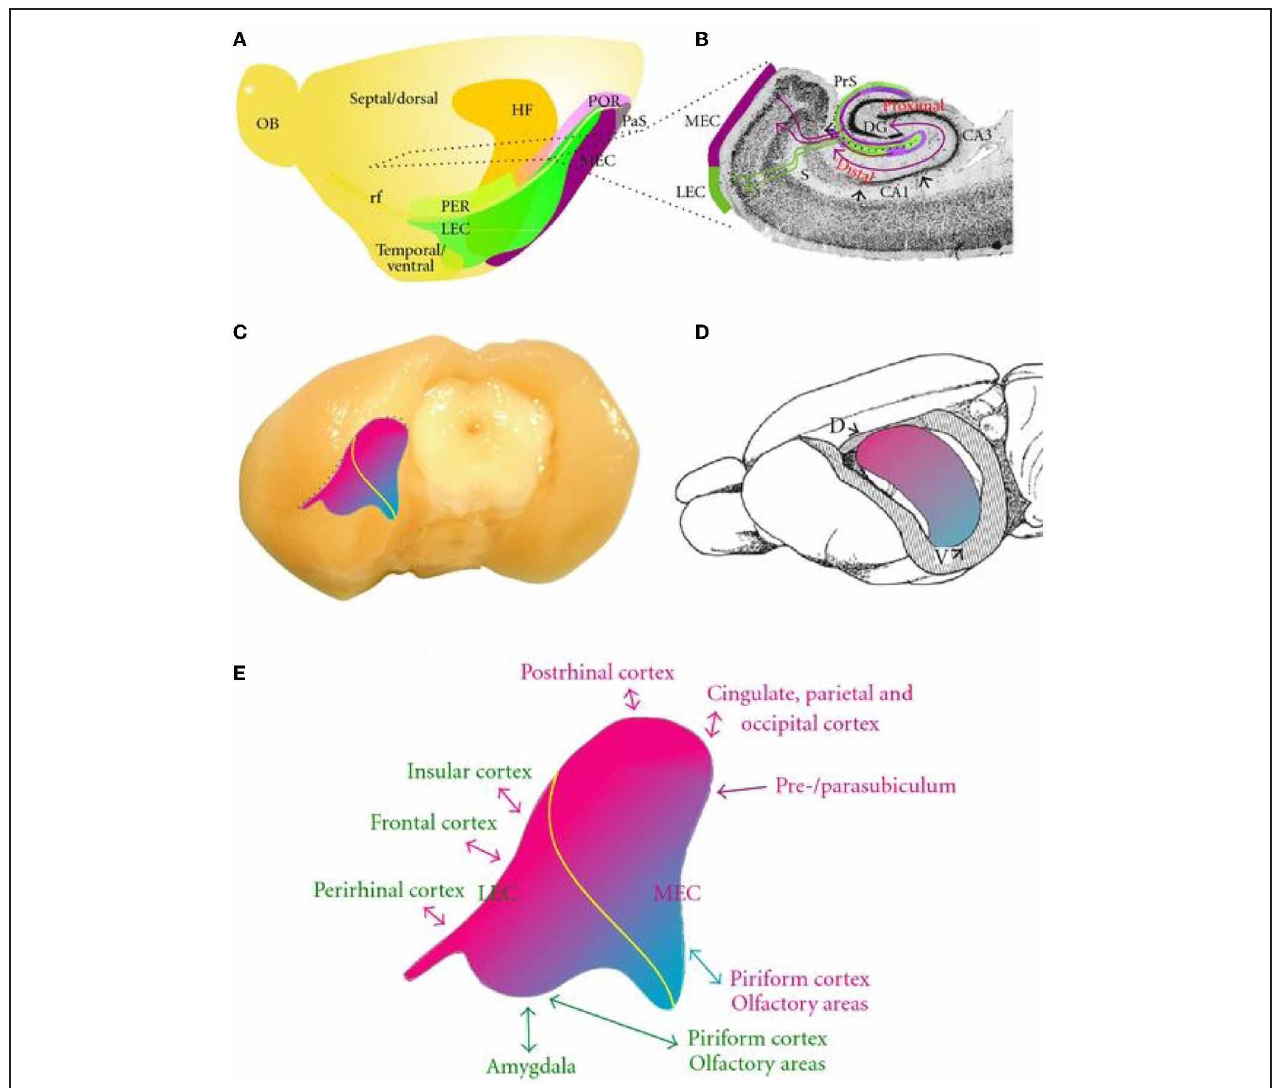
FIGURE 1 | Schematic representation of the overall organization of the entorhinal cortex and its connectivity. (A) Position of the entorhinal cortex and surrounding cortices and hippocampus in the rat left hemisphere. Indicated are the dorsoventral extent of the hippocampus, positions of LEC and MEC, and the approximate position of a representative horizontal section, illustrated in (B) . (B) Horizontal section illustrating entorhinal-hippocampal connectivity (see text for more details). (C) and (D) Representation of the topographical arrangement of entorhinal-hippocampal reciprocal connections. A dorsolateral band of entorhinal cortex (magenta) is preferentially connected to the dorsal